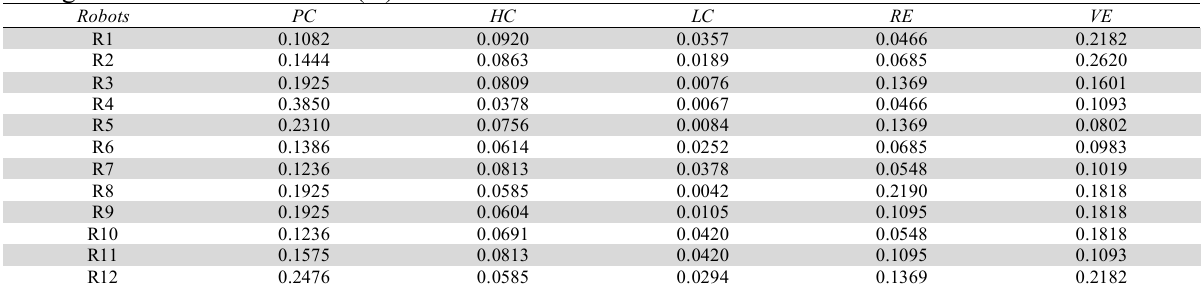
Weighted Normalized Matrix (V)